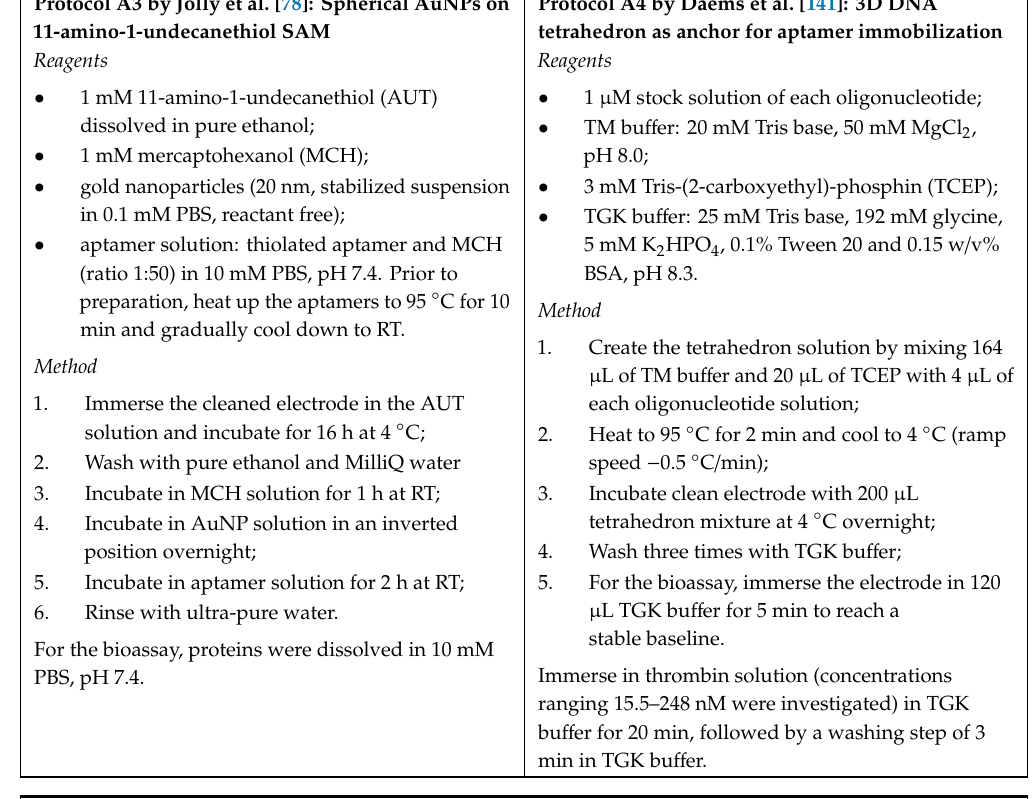
Protocol A3 by Jolly et al. [78]: Spherical AuNPs on Protocol A4 by Daems et al. [141]: 3D DNA